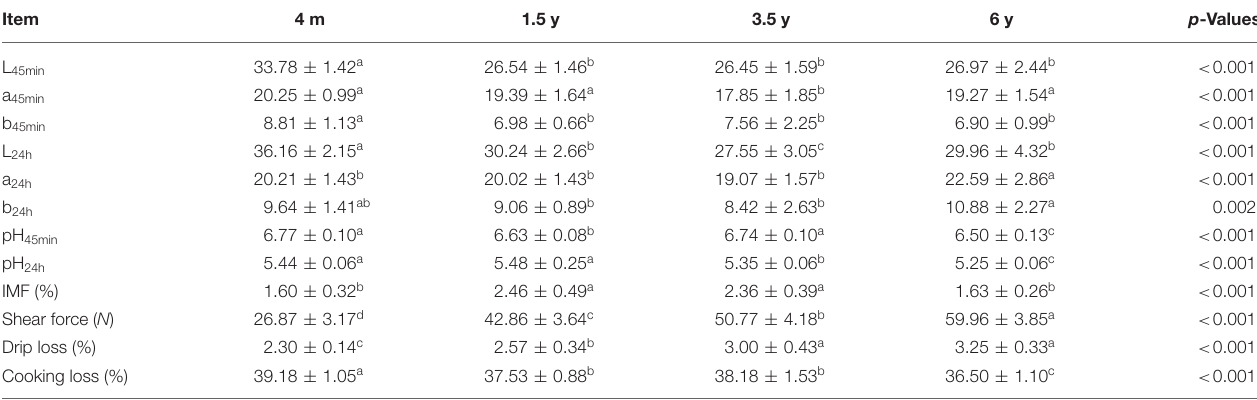
TABLE 2 | Effect of different muscle fiber types on meat quality for Tibetan sheep slaughtered at different ages.